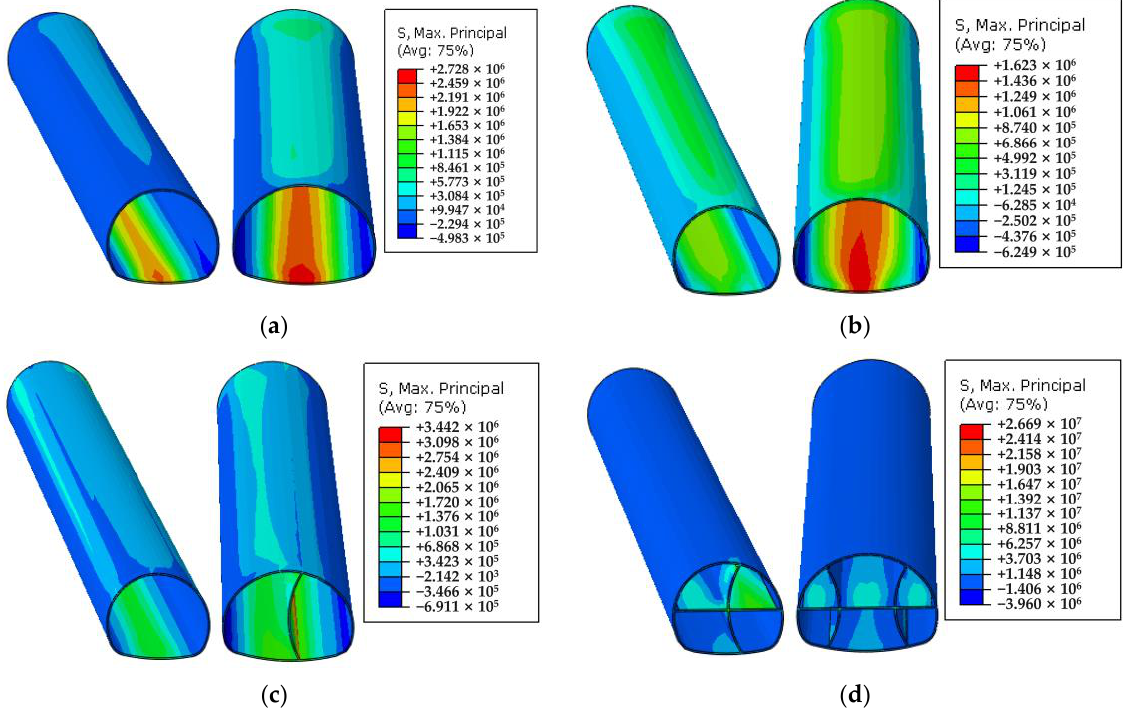
Figure 11. Maximum principal stress of lining structure (unit: Pa): ( a ) Step method; ( b ) Full section method; ( c ) CD method; ( d ) Double wall heading method.